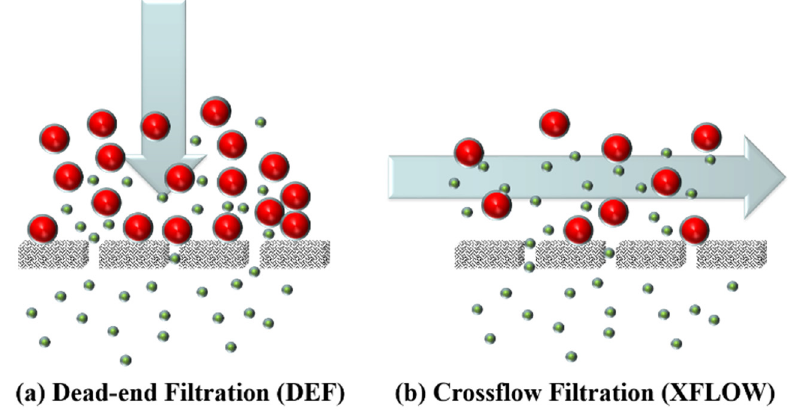
Figure 2. Main flow types in membrane separations: ( a ) Dead-end filtration; and ( b ) Crossflow filtration. Large (red) spheres represent rejected particles, small (green) spheres represent non- rejected particles, and the arrows indicate the feed flow direction. Reproduced with permission from Elsevier.